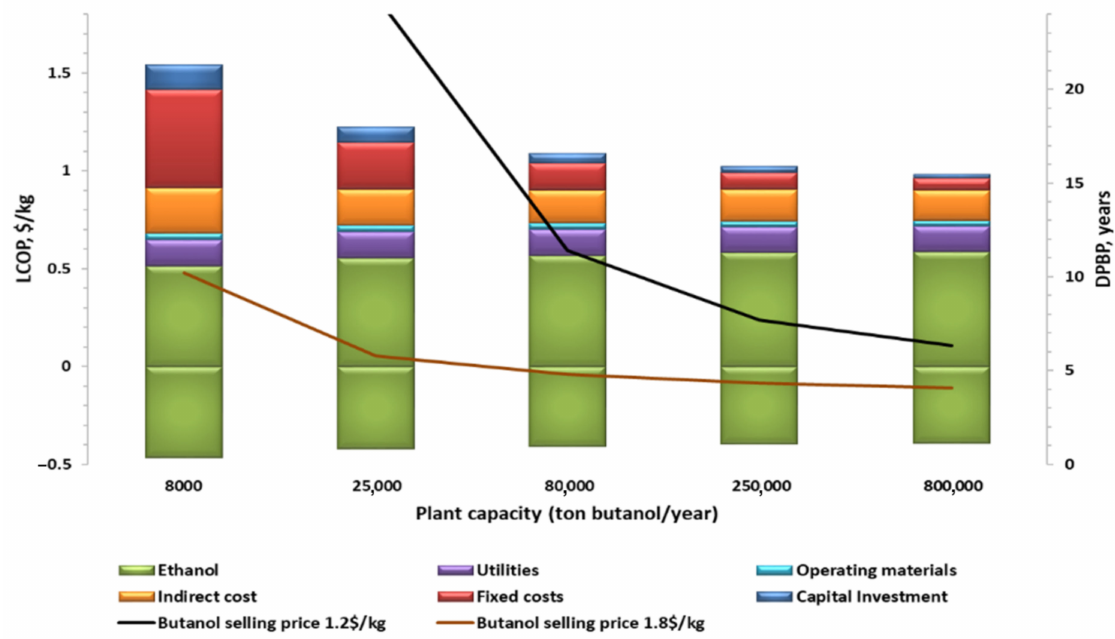
Figure 16. LCOP and DPBP for various plant